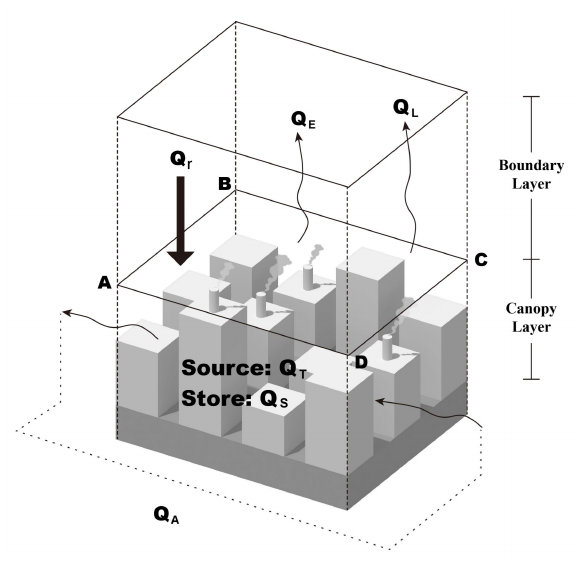
Figure 1. Schematic diagram of the energy fluxes in the urban environment, adapted from [17,21].